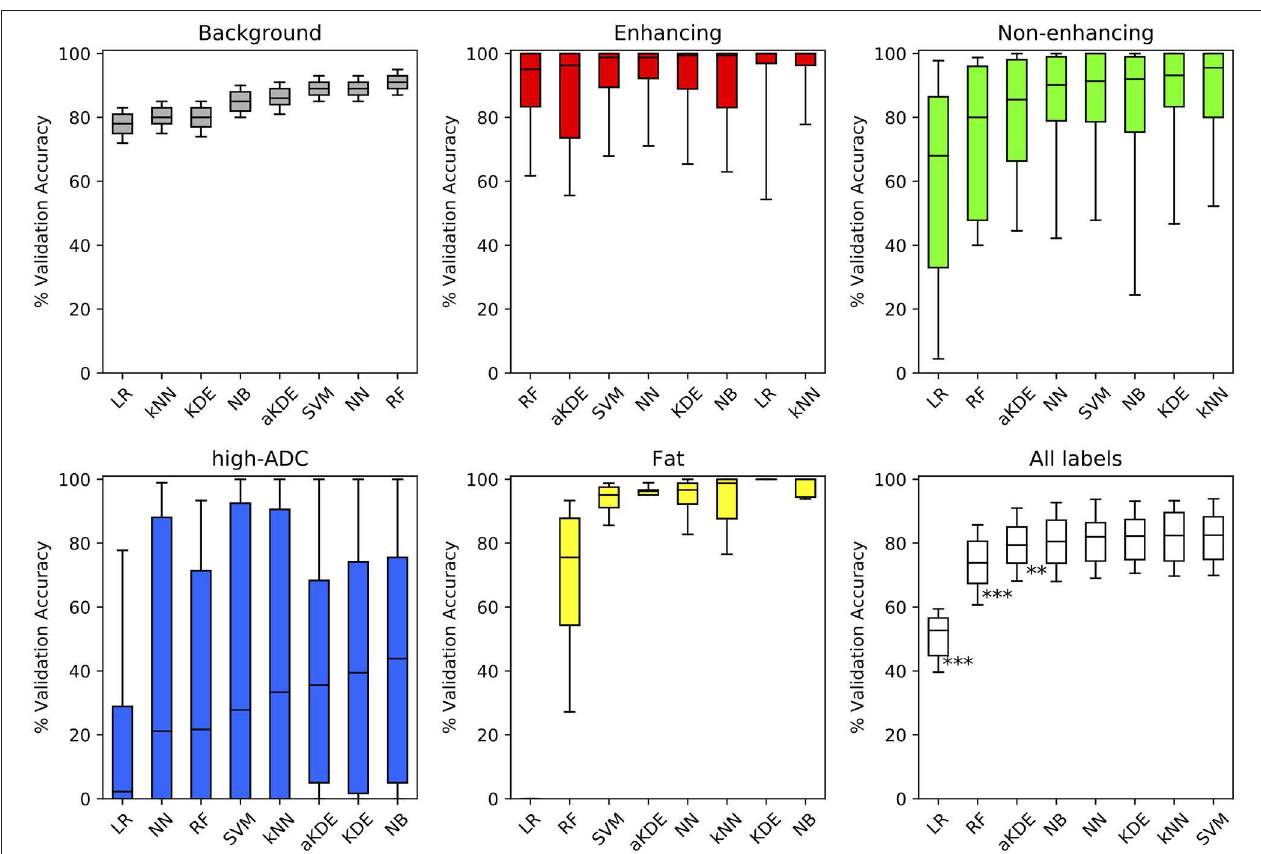
FIGURE 3 | Comparison of the validation accuracy for the different machine learning (ML) techniques applied to our labeled training-set data. Methods are compared for each tissue label separately (colored as per Figure 1 ) and for all tissue types combined (white). Boxplots demonstrate the distribution of validation accuracies (derived using a randomized cross-validation approach) following optimization of hyper-parameters (bold-lines represent median, shaded areas indicate the inter-quartile range and whiskers the 5th/95th percentiles). Methods are ordered from left to right in order of increasing median accuracy (** p < 0.005, *** p <